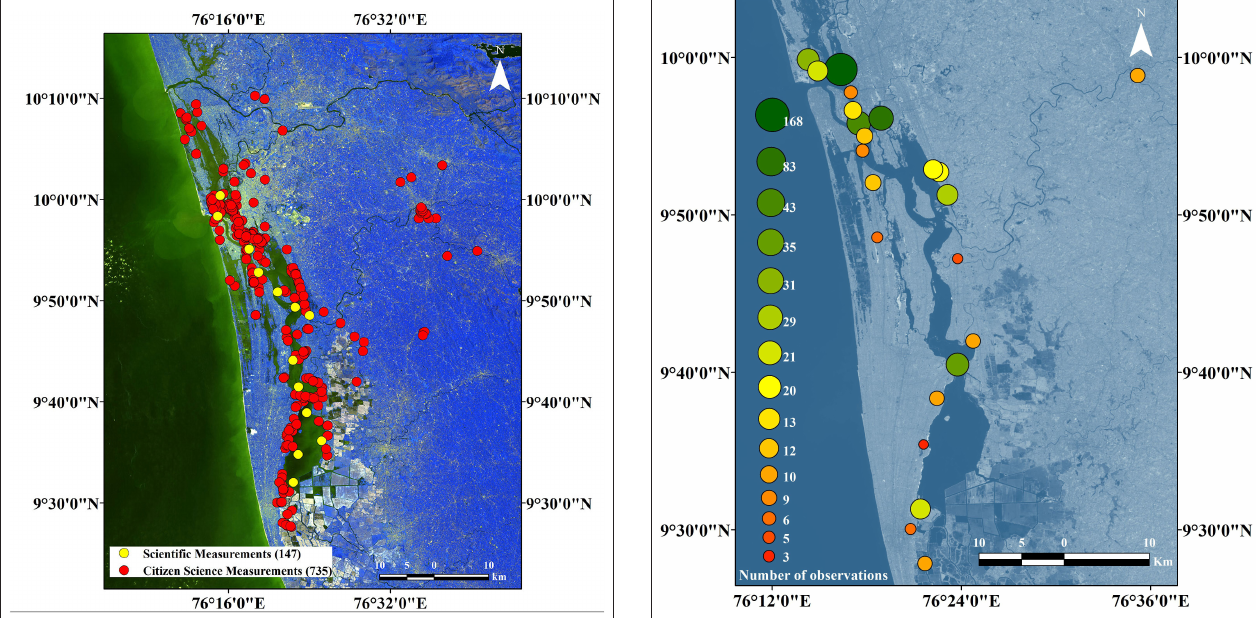
FIGURE 3 | Total number of data points collected by the citizen scientists from the Vembanad Lake.